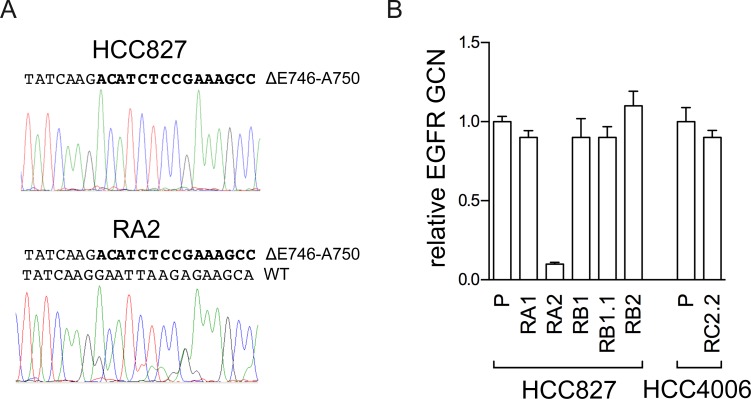
Analysis of the EGFR gene in the RA2 ERL-resistant cell line.A) Analysis of EGFR exon 19 nucleotides sequence. The pherogram of the parental cell line with peaks corresponding to the EGFR mutated sequence (ΔE746-A750) and the pherogram of the RA2 resistant cells with peaks corresponding to the mutated and wild type (WT) EGFR nucleotides sequence are shown. B) qPCR analysis. Relative EGFR gene copy number (GCN) in genomic DNA, normalized to the Rnase P gene, is expressed relative to the levels in parental cell lines (P) set as 1 (mean ± SD of triplicate determinations). Results are representative of those obtained from 2 independent analysis.